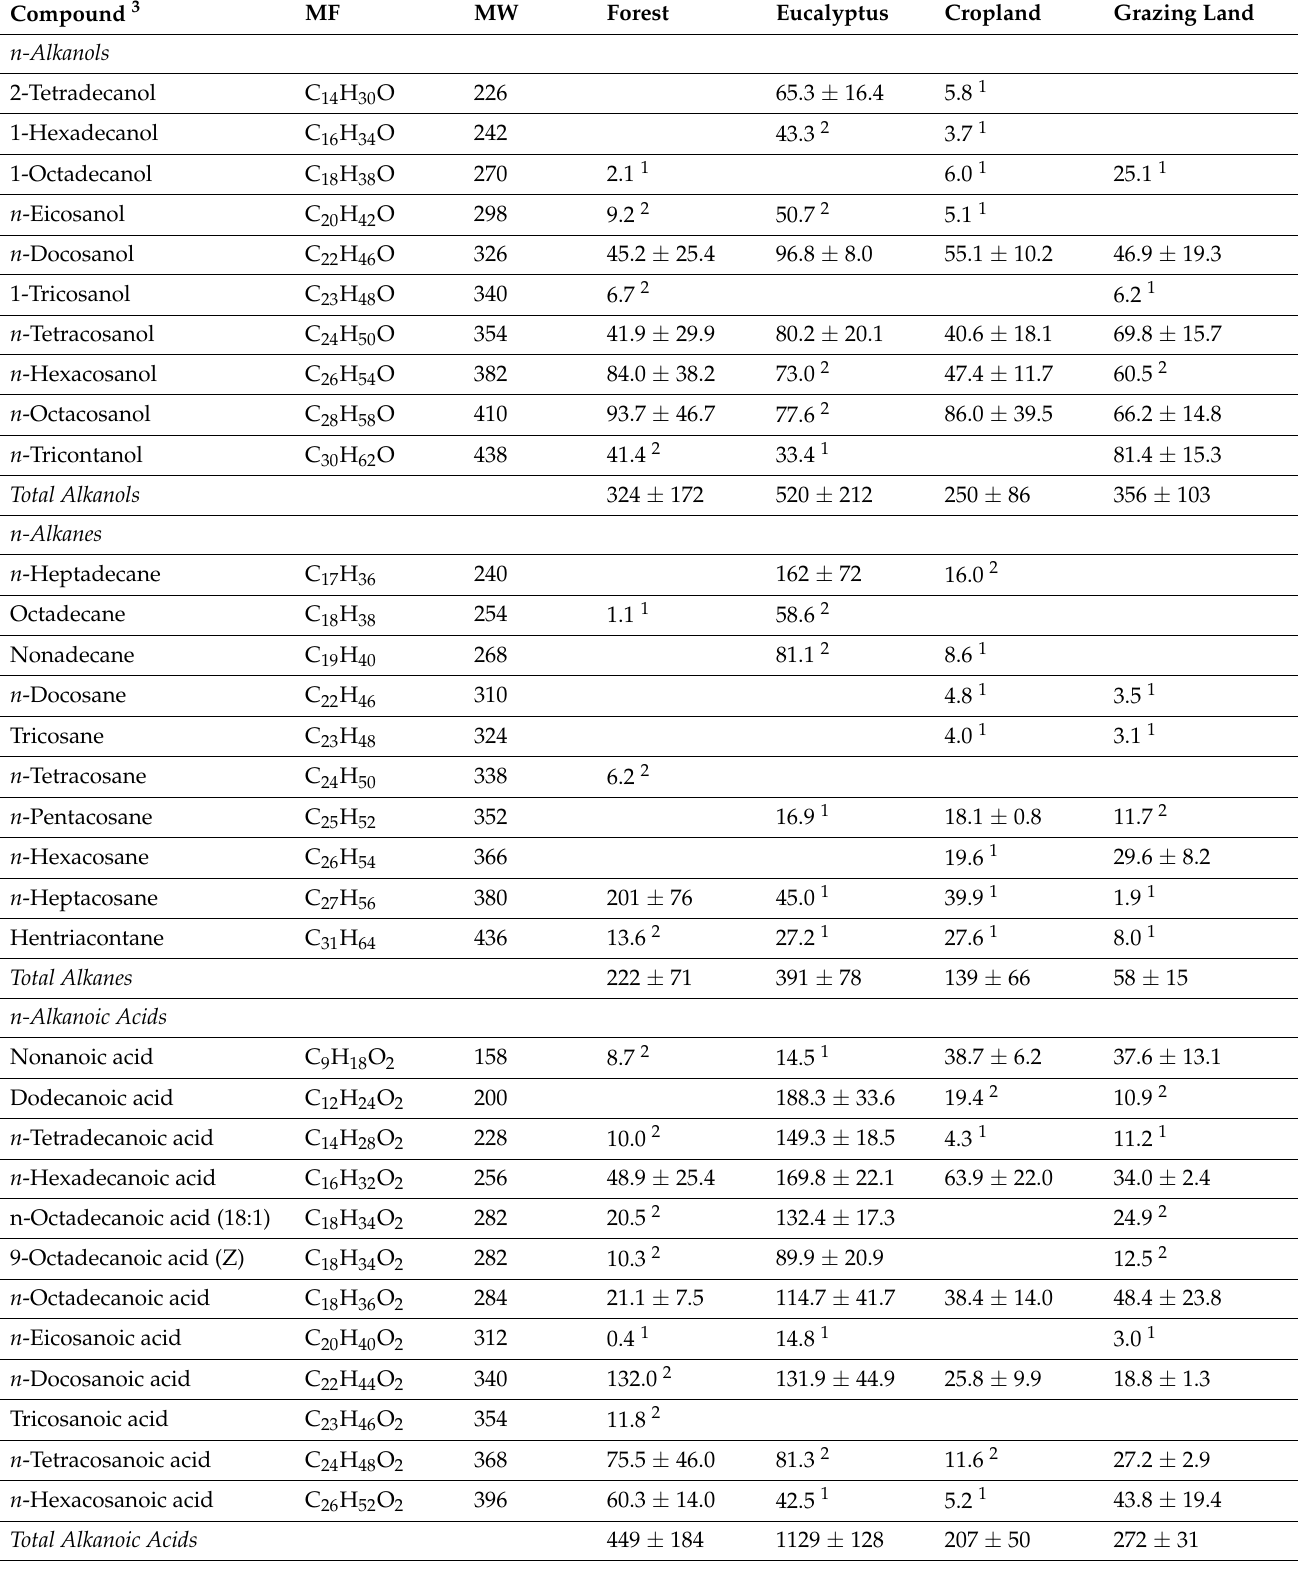
Table A1. Compounds ( µ g g − 1 C) identified in the solvent extracts of soil samples from different land-use systems in Gelawdios, Ethiopia. MF, molecular formula; MW, molecular weight. Values are mean ± SE; n =1–3 (see table